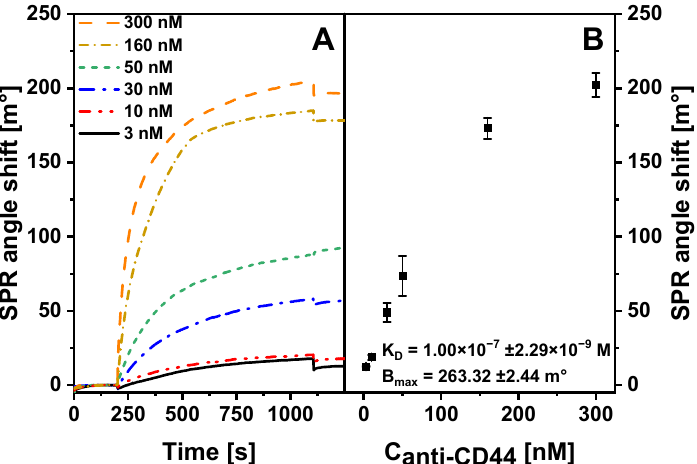
Figure 5. ( A ) SPR study of immune complex formation between immobilized CD44 protein and anti- CD44 antibody at concentrations of 3, 10, 30, 50, 160 and 300 nM. ( B ) The dependence of SPR response on concentration of anti-CD44 antibodies. The SPR response was calculated as the difference between the SPR signal at the end of the dissociation phase and at the beginning of the association